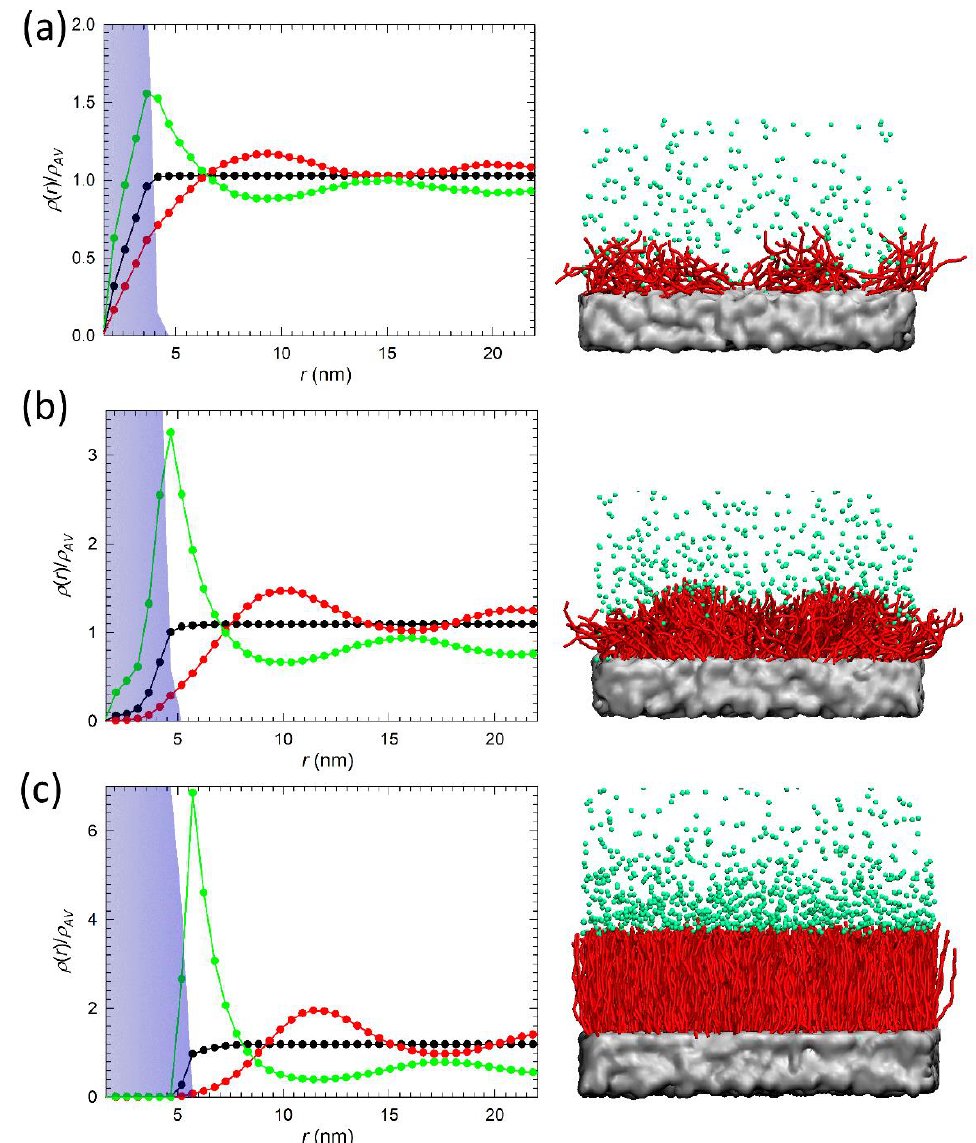
Figure 3. Left column: Averaged density distribution ρ ( r ) for coatings grafted by alkylamine chains with N = 12 beads at ( a ) low grafting density σ = 0.8 chains / nm 2 , ( b ) intermediate grafting density σ = 2.5 chains / nm 2 , and ( c ) high grafting density σ = 6 chains / nm 2 . Each density distribution is scaled to the average density of the species, ρ AV , in the system. Green, red, and black lines represent anions, cations, and water, respectively. The blue area highlights the coating layer. Right panel: corresponding simulation snapshots where cations and water beads are omitted for clarity. Green spheres represent anions, red sticks the alkylamine chains, and the PEG / PEI surface is displayed in silver.